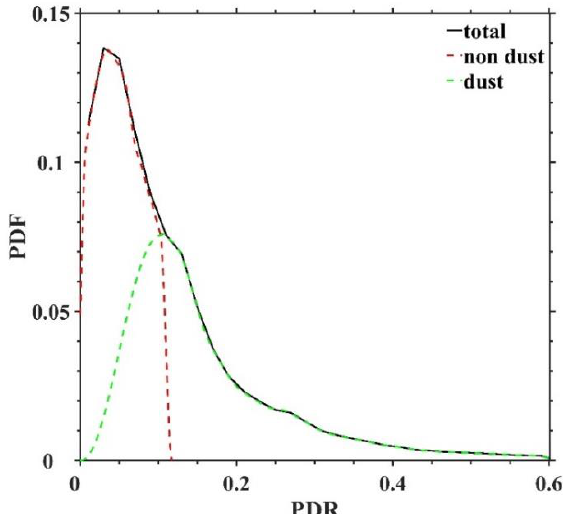
Figure 1. The probability density functions (PDF) of particle depolarization ratio (PDR) for all aerosols observed by MPL from January 2013 to September 2017 at the NSA site. The black line is for all the aerosols derived from MPL observations, while the red and green lines indicate non-dust and dust aerosol modes fitted to the shape of the PDF of all aerosol PDR. A PDR of 0.10 is the cross point of the dust and non-dust aerosol modes.